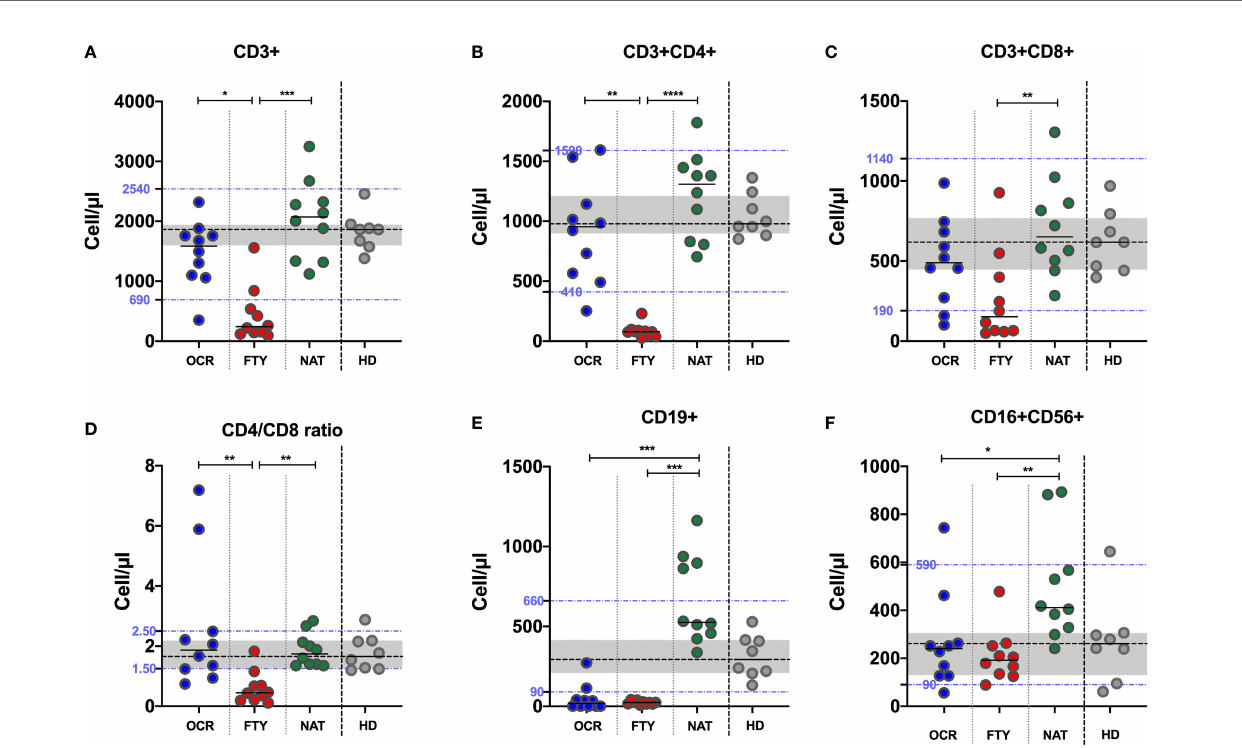
FIGURE 2 | Peripheral blood lymphocyte absolute counts and CD4/CD8 ratio in PwMS on DMTs and HD. Peripheral blood CD3+ (A) , CD4+ (B) , CD8+ (C) , CD19+ (E) , CD16+CD56+ (F) lymphocyte absolute counts and CD4/CD8 ratio (D) were assessed in PwMS. The differences among the three groups were assessed using the Kruskal-Wallis test, and the Dunn ’ s multiple comparison post-test, after correction for multiple comparisons. The level of statistical signi fi cance is reported. (A – E) . Horizontal continuous segments represent medians. Horizontal dotted black line and the gray area represent the median value and the interquartile range [IQR] observed in 9 healthy donors age and sex matched with PwMS. Horizontal dotted blue lines represent the lower and upper limit of the normality range of the laboratory for peripheral blood lymphocyte absolute counts. PwMS, people with multiple sclerosis; OCR, ocrelizumab group (blue); FYT, fi ngolimod group (red); NAT, natalizumab group (green); HD, healthy donors (gray). * p<0,05; ** 0,01<p< 0,001; *** 0,001<p< 0,0001; ****